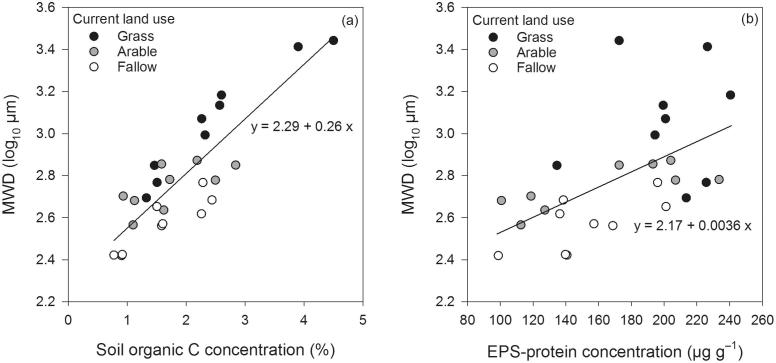
Stable aggregate mean weight diameter (MWD) as a linear function of (a) soil organic C concentration (y-axis), and (b) EPS-protein concentration. Current grass, arable and fallow land uses are shown (black, grey and white symbols, respectively). See Table 3 for further details of the linear regression analyses.